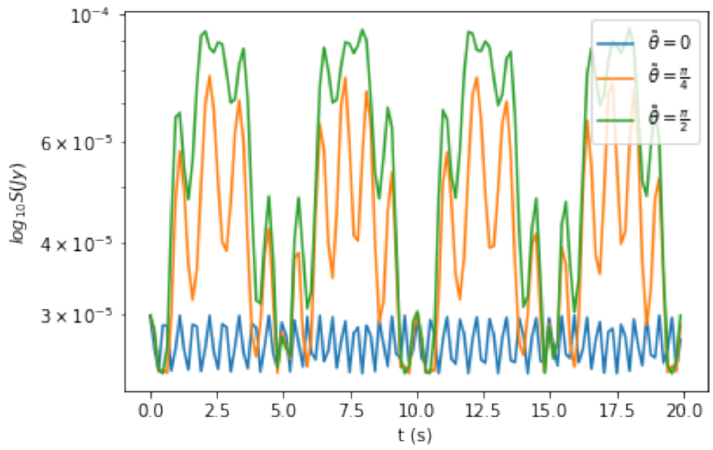
Figure 3 . Spectral flux density versus time for e=0. The blue colour represents the rotation axis on the z axis, while orange and green represent the rotation axis at ˜ θ = π